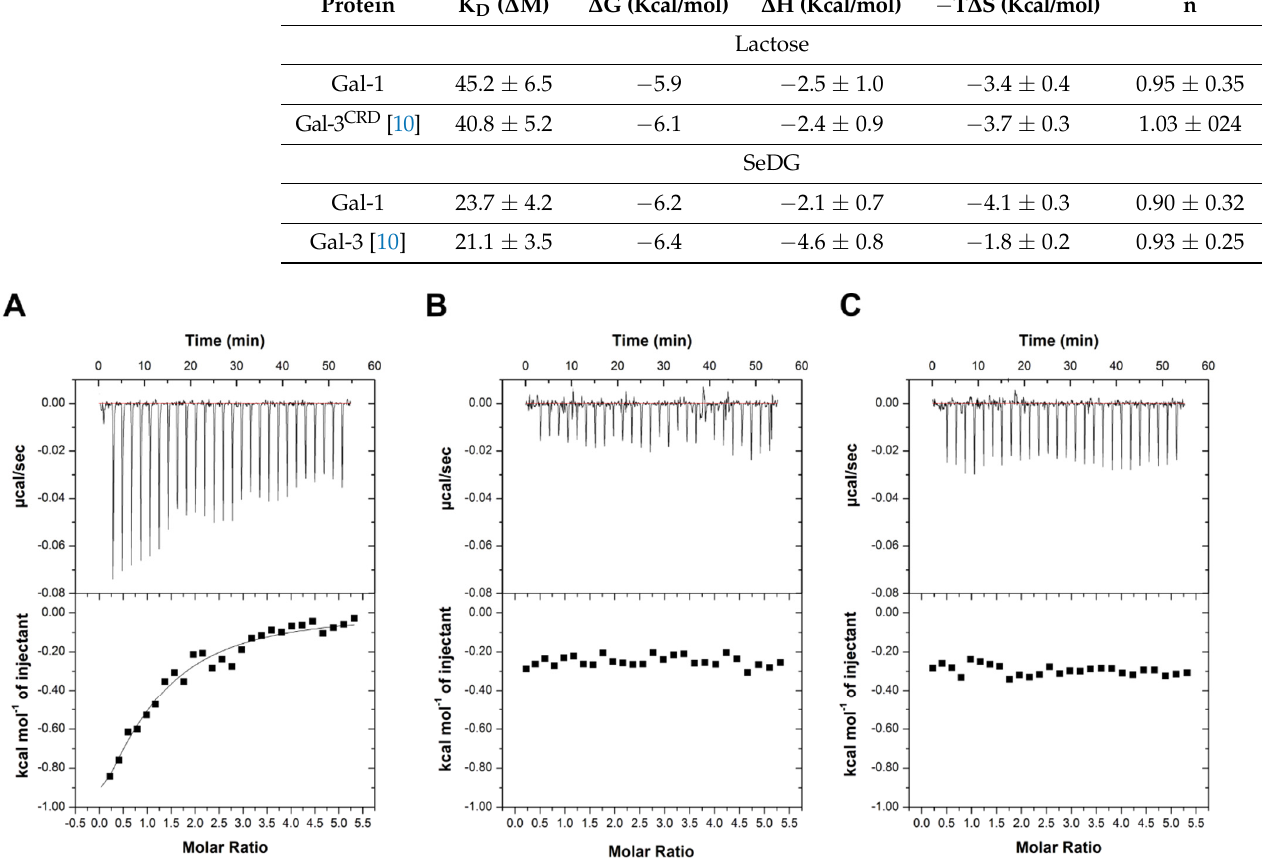
Table 2. Thermodynamic binding parameters from the isothermal titration calorimetry measurements of Gal-1 and Gal-3 CRD titrated with lactose (positive control) and SeDG at 298 K.